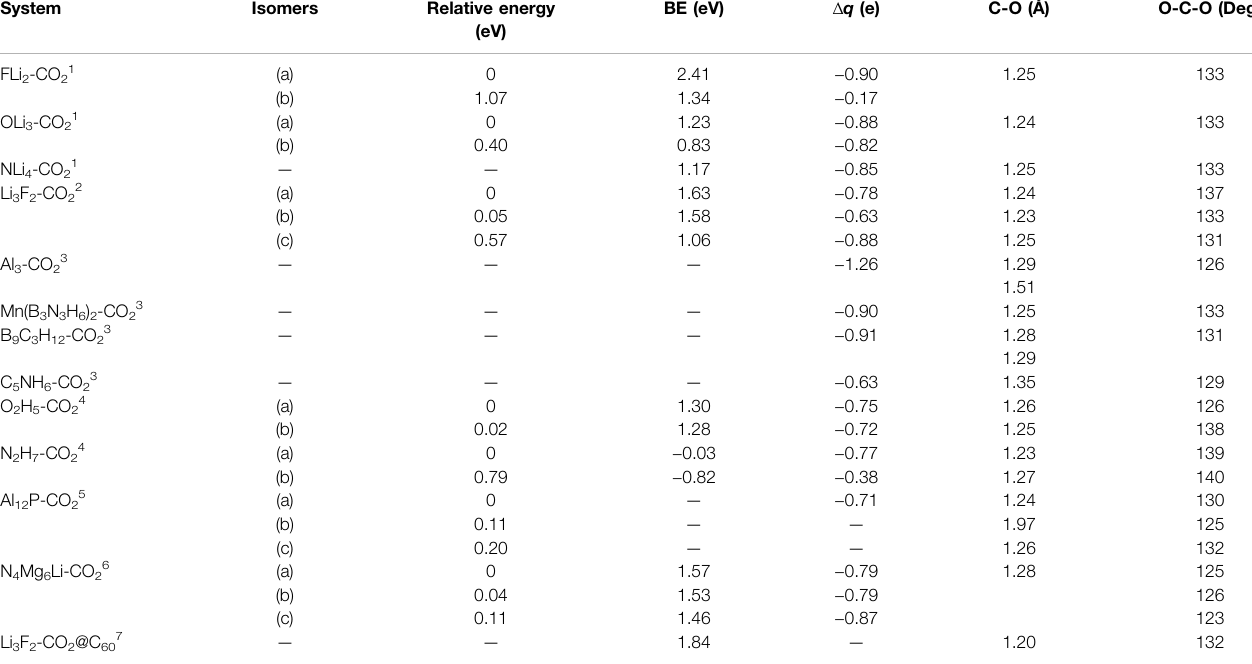
TABLE 1 | Relative energy, binding energy (BE), NPA charge ( Δ q ), bond length (C-O), and bond angle (O-C-O) of the complexes of CO 2 with various superalkalis. System